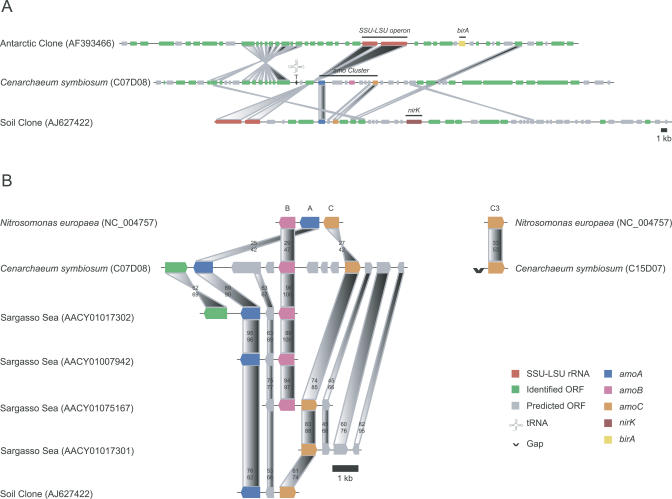
Relationship of
C. symbiosum Ammonia Monooxygenase
(amo) Gene Cluster to Other Uncultivated Crenarchaeal Sequences
(A) Comparison of the genomic interval containing ammonia monooxygenase genes in
C. symbiosum with two related environmental fosmid sequences, one obtained from mesopelagic seawater (AF393466) and the other from terrestrial soil (AJ627422).
(B) Comparison of the order and composition of the
C. symbiosum ammonia monooxygenase
(acc) gene cluster and unlinked
amoC3 locus in relation to the bacterial operon from
N. europaea, several highly related contig intervals identified in the environmental database of SAR WGS sequences, and a terrestrial soil sequence. Protein identity (top) and similarity (bottom) percentages between predicted gene products identified in
C. symbiosum are shown within the corresponding shaded boxes. See
Tables S1–
S3 for more information.